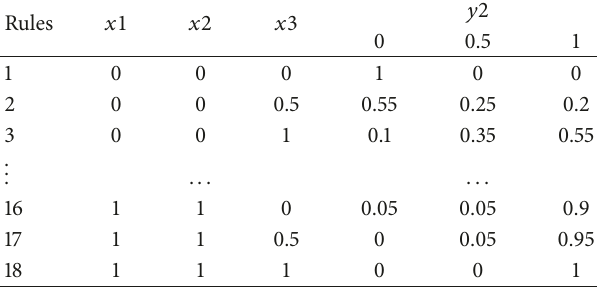
Table 5: The fuzzy gate rules for imbalance of rotor’s quality.